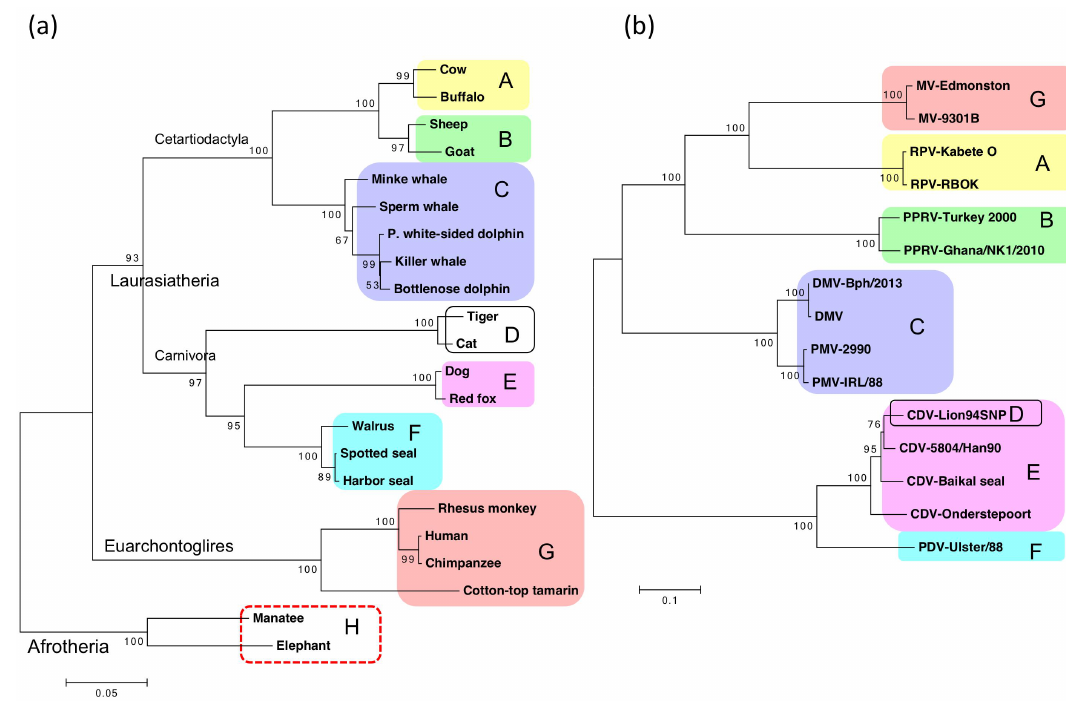
Figure 2. Phylogenetic trees of full-length signaling lymphocyte activation molecules (SLAMs) ( a ) and full-length morbillivirus hemagglutinin (H) proteins ( b ). Neighbor-joining methods were implemented in MEGA7 [142,143]. The bootstrap probabilities with 500 replications are shown at the nodes. Respective pairs of host animals and corresponding morbilliviruses are shown as squares with the same color and same alphabetic notations: A, large ruminants; B, small ruminants; C, cetaceans; D, felids; E, canids; F, pinnipeds; G, primates. Morbilliviruses have not been identified in manatees and elephants (H, red dashed box). The amino acid sequences of full-length SLAMs were obtained from the Data Bank of Japan: cow ( Bos taurus , AAK61860.1); bu ff alo (